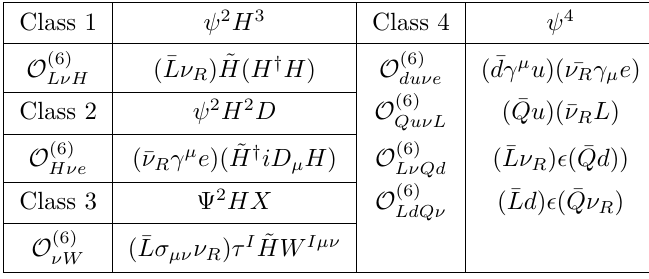
Table 3 . LNC dim-6 operators [76] involving a sterile neutrino that a(cid:11)ect 0 (cid:23)(cid:12)(cid:12) at tree level.